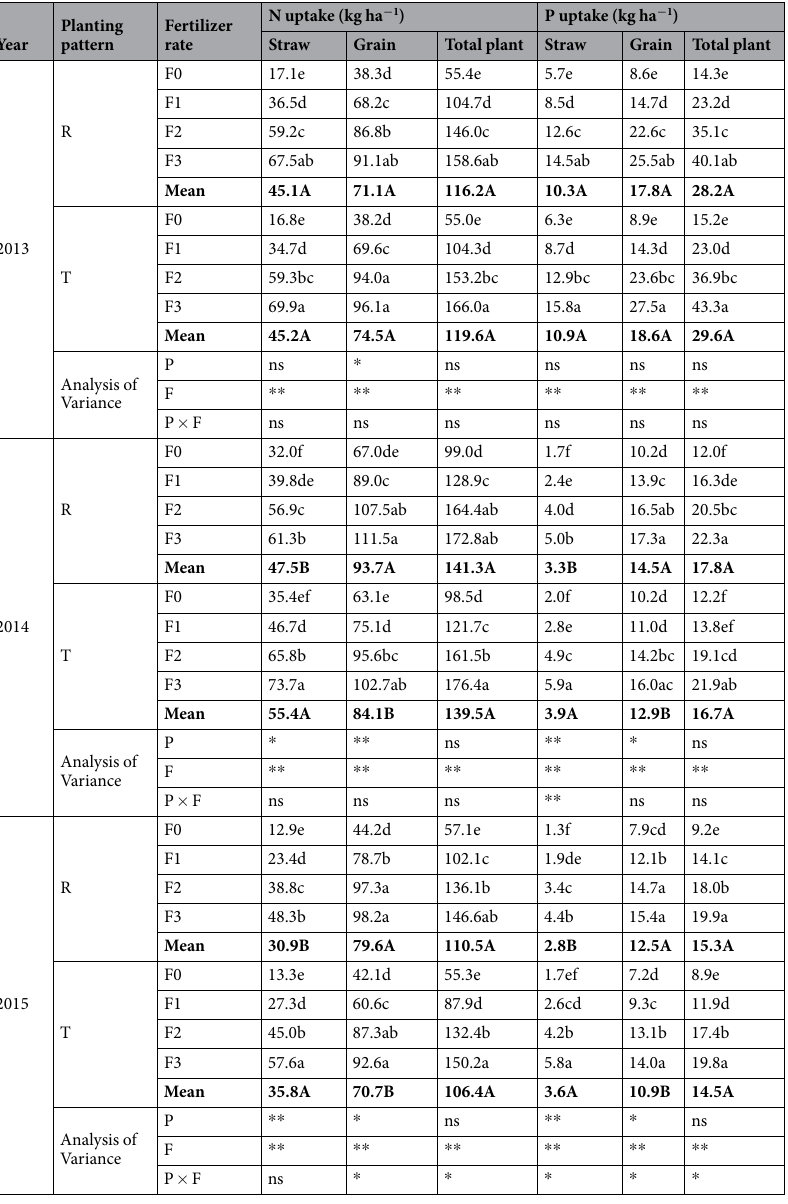
Table 2. Effects of planting pattern and fertilizer rate on nitrogen (N) and phosphorus (P) uptake by foxtail millet at harvesting during